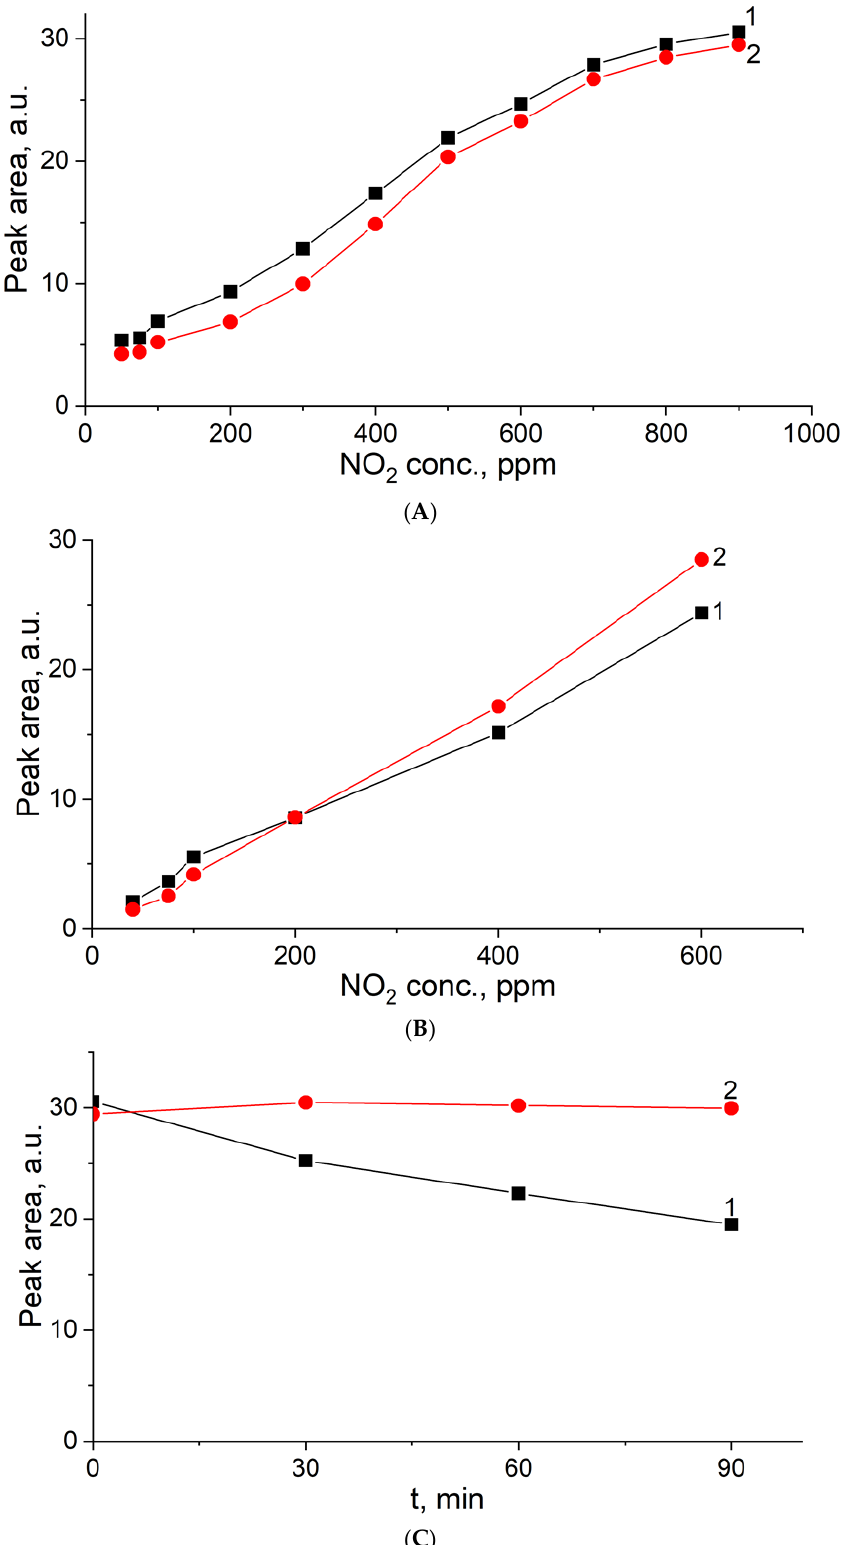
Figure 7. ( A ) Evolution of the IR peak areas following NO 2 detection by Sn-BEA zeolite: 1800 – 1600 Figure 7. ( A )Evolution oftheIR peakareasfollowingNO 2 detectionby Sn-BEAzeolite: 1800–1600 cm − 1 (1), cm −1 (1), 1500 – 1300 cm −1 (2). ( B ) Evolution of the IR peak areas following NO 2 detection by DeAl- 1500–1300 cm − 1 (2). ( B ) Evolution of the IR peak areas following NO 2 detection by DeAl-BEA zeolite: 1800–1600 cm − 1 (1), 1500–1300 cm − 1 (2). ( C ) Evolution of the IR peak areas of NO 2 detection by Sn-BEA zeolite upon desorption in Ar flow at room temperature: 1800–1600 cm − 1 (1) and 1500–1300 cm − 1